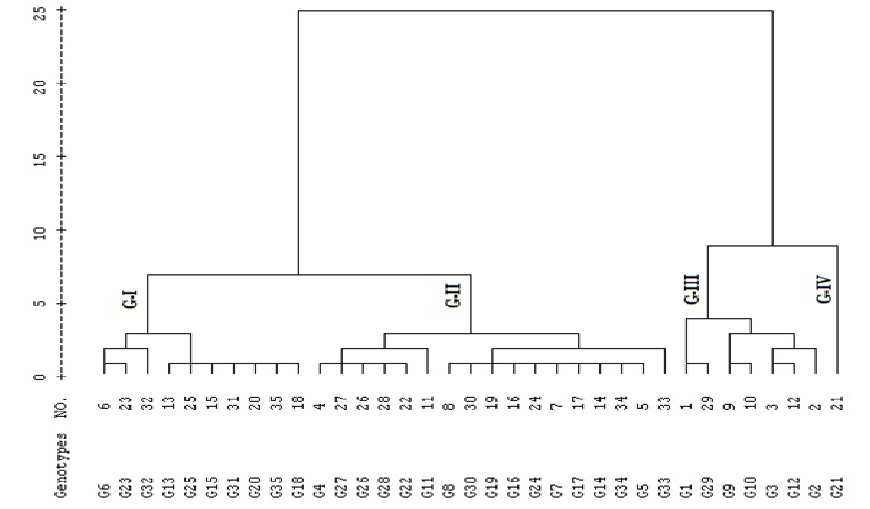
Fig. 5. Dendrogram resulting from cluster analysis of 35 durum wheat genotypes based on ZnE, STI, RDI, YI, YSI, DI, ATI, SSPI, SDI, K 1 STI, and K 2 STI indices for grain yield in normal (GYp) and zinc stress (GYs) conditions. The numbers inside the figure are genotypes code (see Table